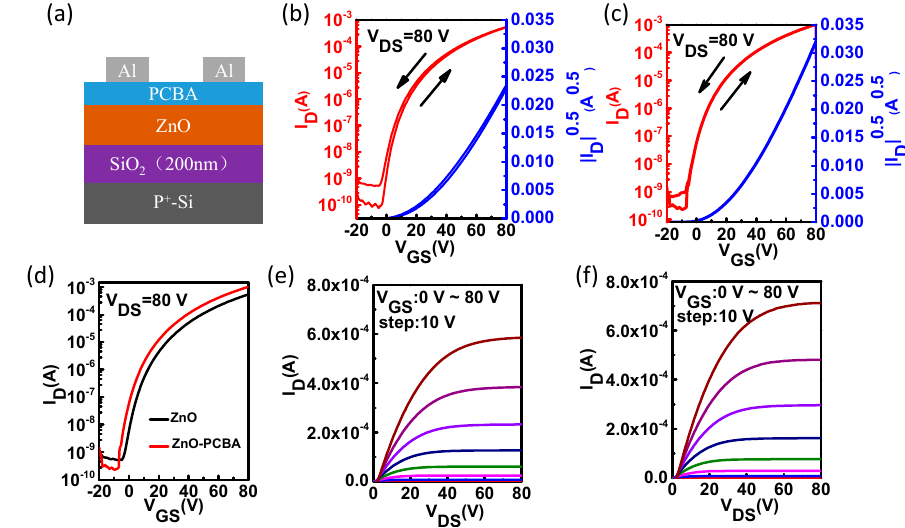
Figure 3. ( a ) Schematic of the thin film transistors (TFTs) structure. ( b – f ) Typical average transfer and output characteristics of the pristine ZnO TFTs ( b , e ), the ZnO TFTs with PCBA interfacial modification layers ( c , f ), and the transfer characteristics of the pristine ZnO TFTs and the ZnO TFTs with PCBA interfacial modification layers ( d ). Table 1. The electrical characteristics of the pristine ZnO thin film transistors (TFTs) and the ZnO TFTs with 4-chlorobenzoic acid (PCBA) interfacial modification layers with Al electrodes. The average results are calculated based on 12 devices.